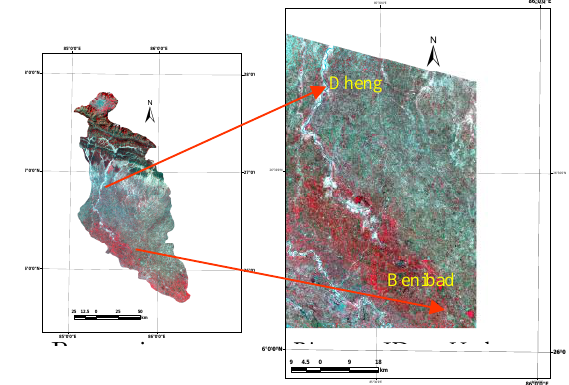
Figure 1.2. FCC map of Bagmati basin with HD model